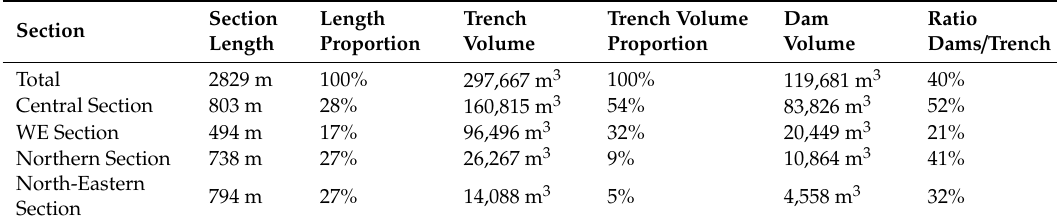
Figure 11. Spatial distribution of excavated volume of the Fossa Carolina. Volume amounts are given in m³ per cell (0.25 m²). Table 4. Relative amounts of excavated volume of individual Fossa Carolina sections.